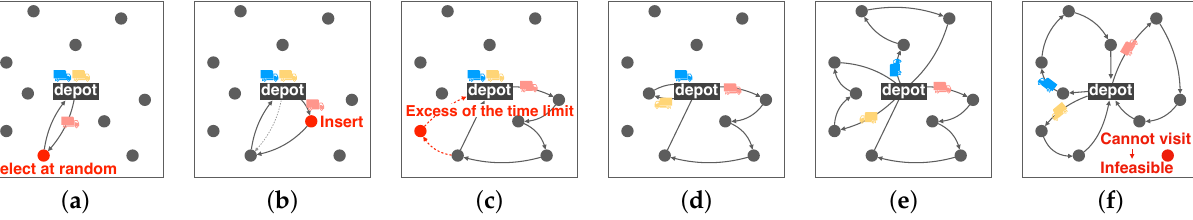
Figure 3. The cheapest insertion method. Black rectangles indicate depots and circles represent ports. ( a ) A red port is randomly selected and visited by the pink vehicle. ( b ) An unvisited port is inserted. ( c ) If the travel time of the pink vehicle exceeds the time limit after inserting the red port, ( d ) another vehicle (yellow) visits the nearest port from the depot. ( e ) An example of a feasible solution. ( f ) An example of an infeasible solution.